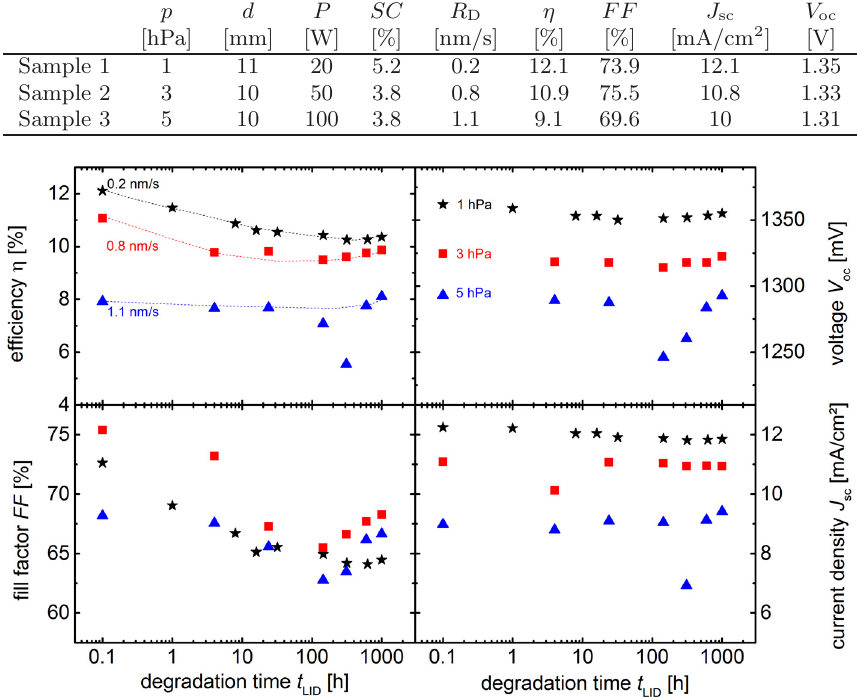
Table 1. Deposition and photovoltaic-parameters for sample 1 (reference process) and samples 2 and 3. Samples 2 and 3 are the samples which show the best efficiency for the sample set where the absorber layer of the bottom solar cell was processed at 3 hPa and 5 hPa, respectively. The deposition parameters are abbreviated as follows: deposition pressure p , electrode distance d , deposition power P , silane concentration SC , and deposition rate R D . The photovoltaic parameters describe the efficiency η , the fill factor FF , the open-circuit voltage V oc , and the short-circuit current density J sc .